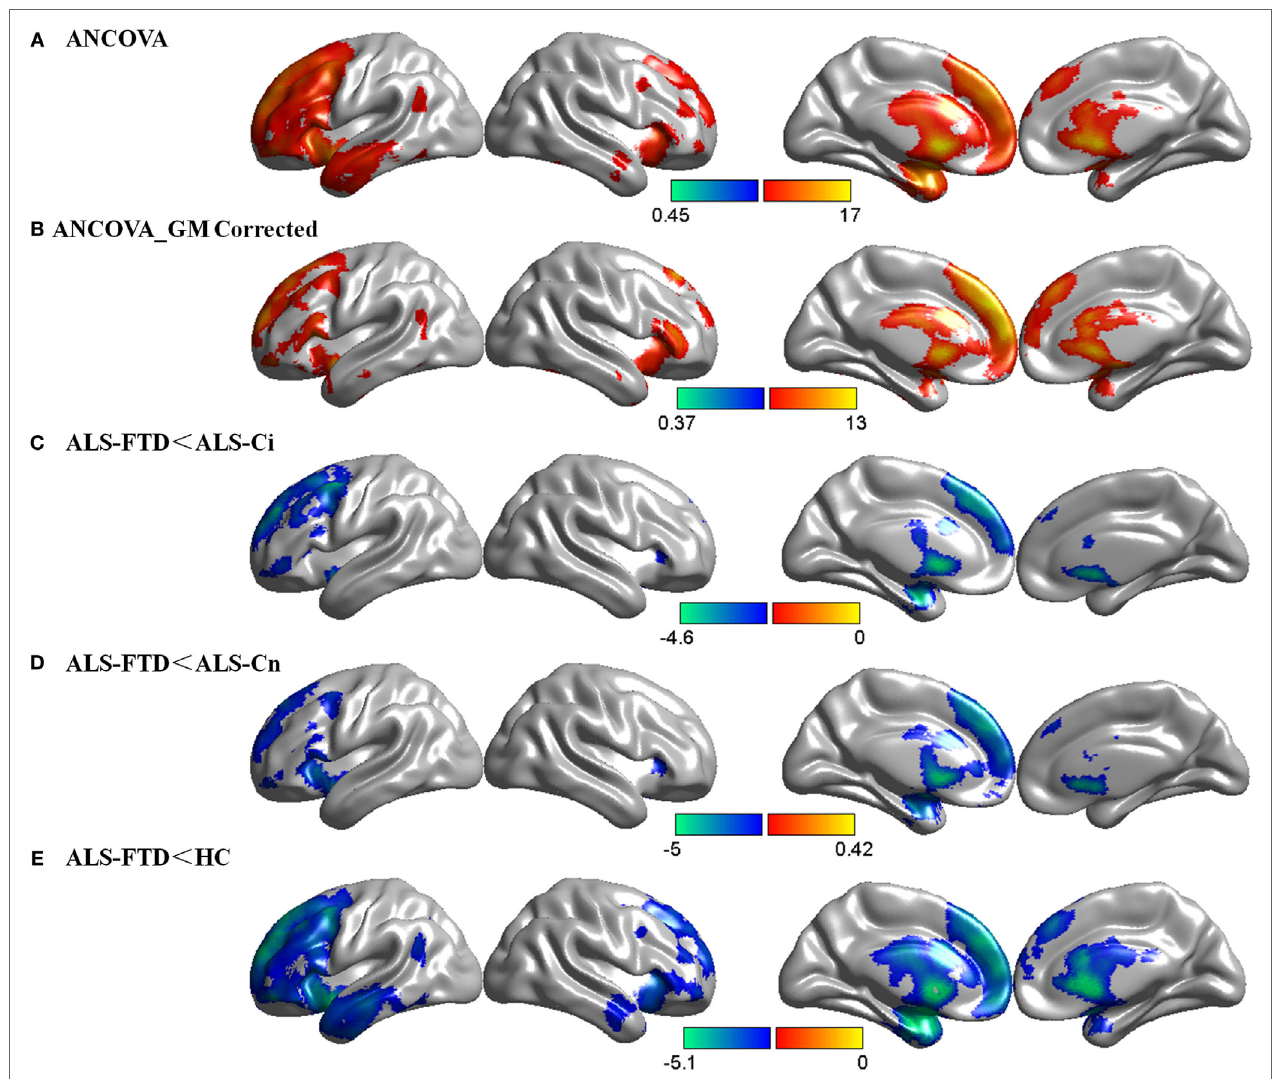
FigUre 2 | Group comparisons of cerebral blood flow (CBF) data. (a) CBF differences among the four subgroups without gray matter (GM) correction. (B) CBF differences among the four subgroups with GM correction. (c) CBF decrease in amyotrophic lateral sclerosis (ALS)-frontotemporal dementia (FTD) patients compared with that in ALS with cognitive impairment (ALS-Ci) patients. (D) CBF decrease in ALS-FTD patients compared with that in ALS with normal cognition (ALS-Cn) patients. (e) CBF decrease in ALS-FTD patients compared with that in healthy controls (HCs). The color bar indicates the range of the F (a,B) or t (c–e) value. For all, p < 0.05 false discovery rate-corrected. The results are visualized using Brant toolbox (version 2.0, http://brant.brainnetome.org/en/latest/).